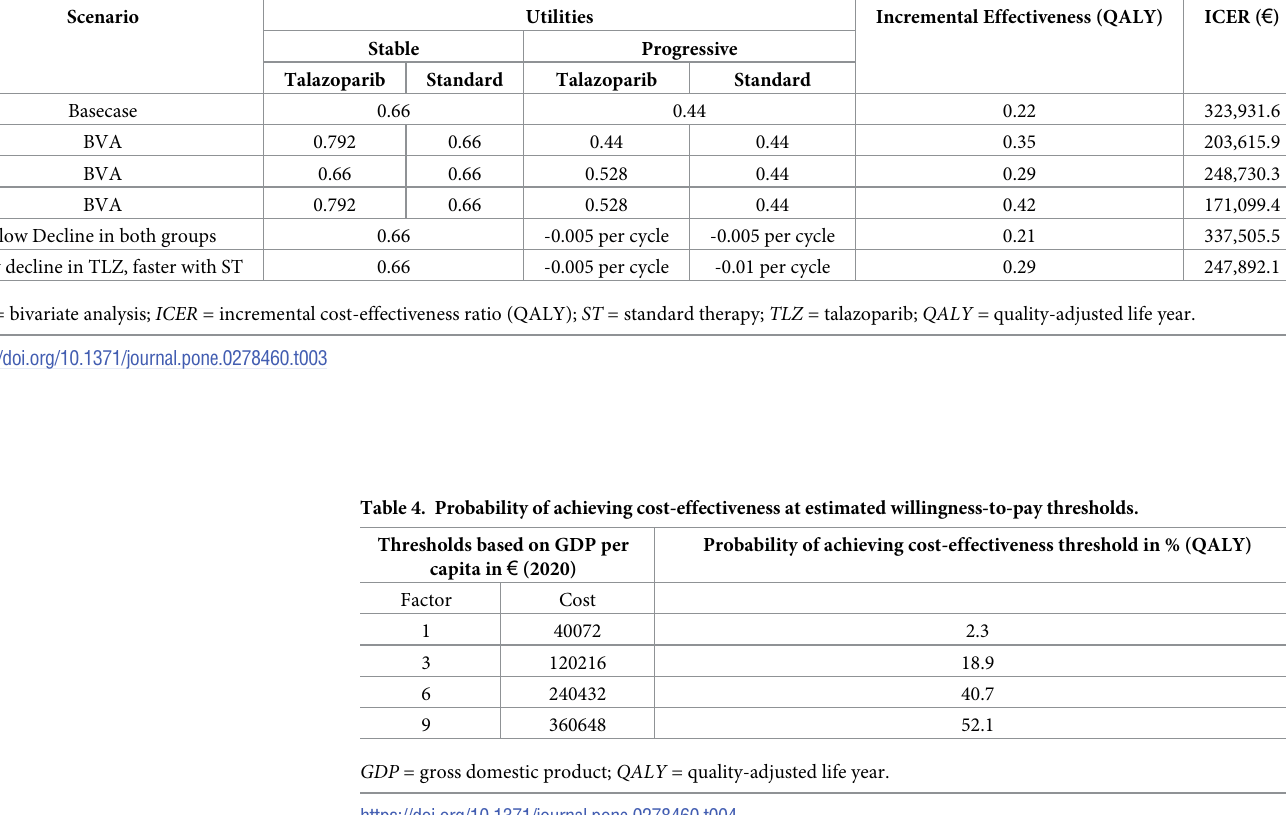
Table 3. Utility scenario analysis.